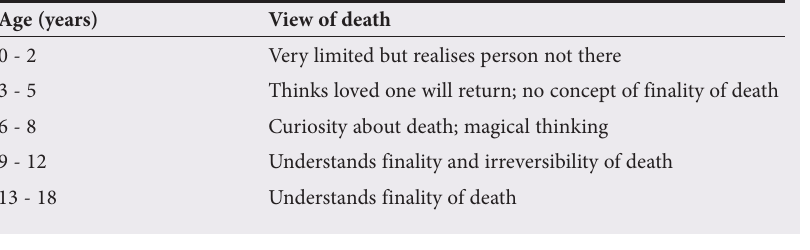
Table 9. Children’s developmental stages of grief [12] Age (years) View of